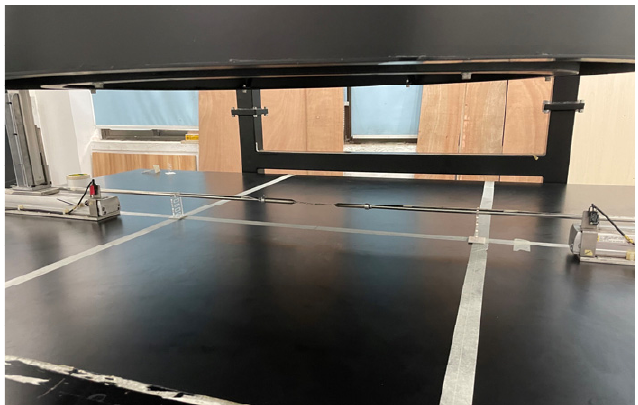
Figure 5. Measurement of tornado wind velocity.